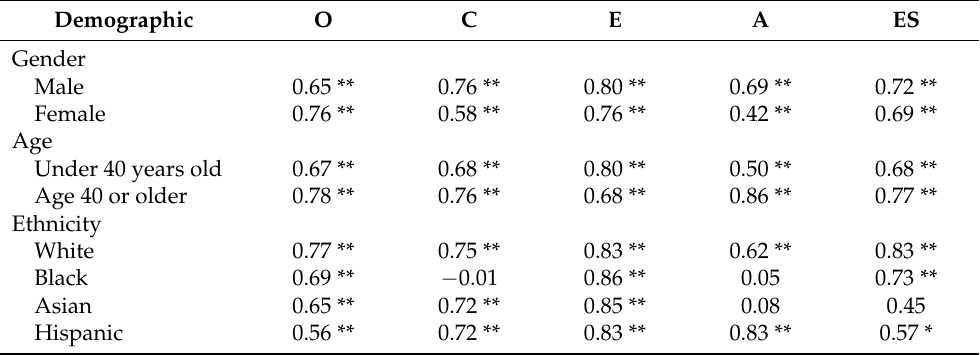
Table 7. The convergent correlations by subgroup. O, C, E, A, and ES refer to Openness, Conscien- tiousness, Extraversion, Agreeableness, and Emotional Stability,